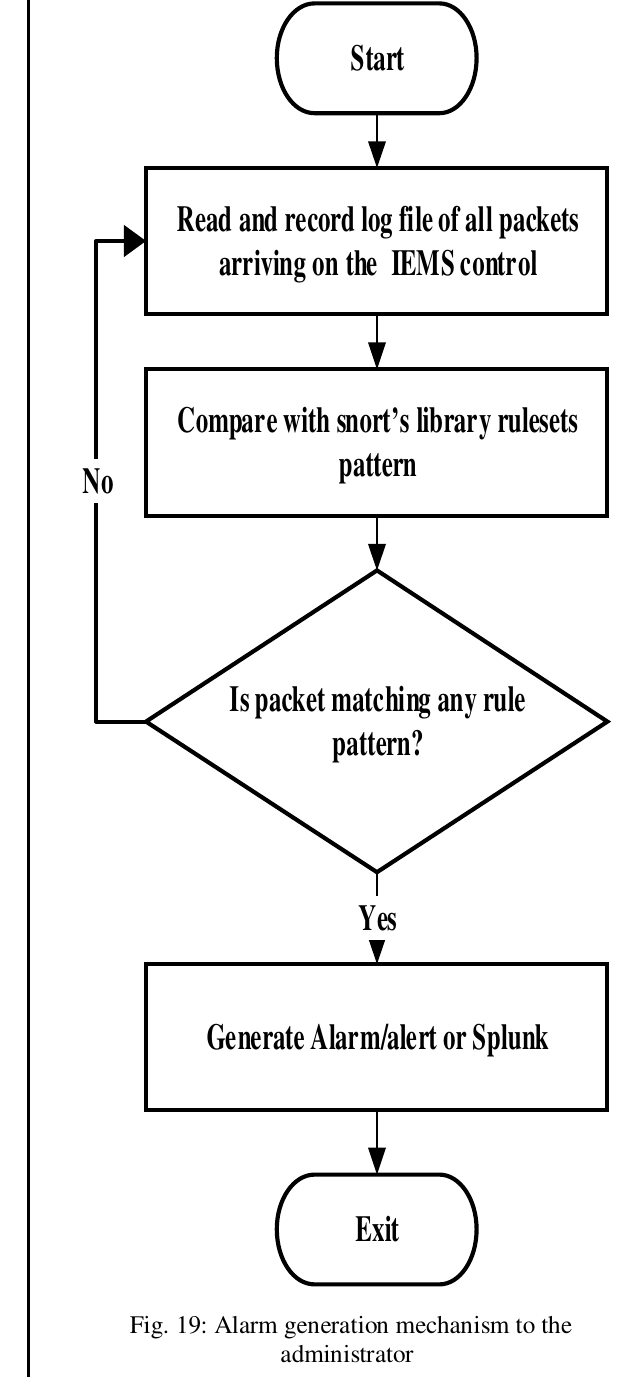
Fig. 19: Alarm generation mechanism to the